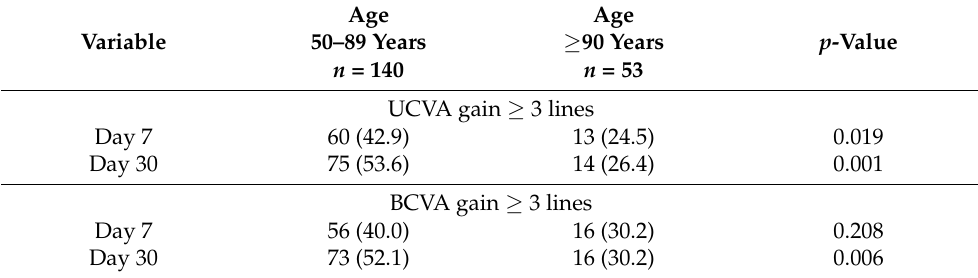
Table 4. UCVA and BCVA at seven and 30 days after cataract